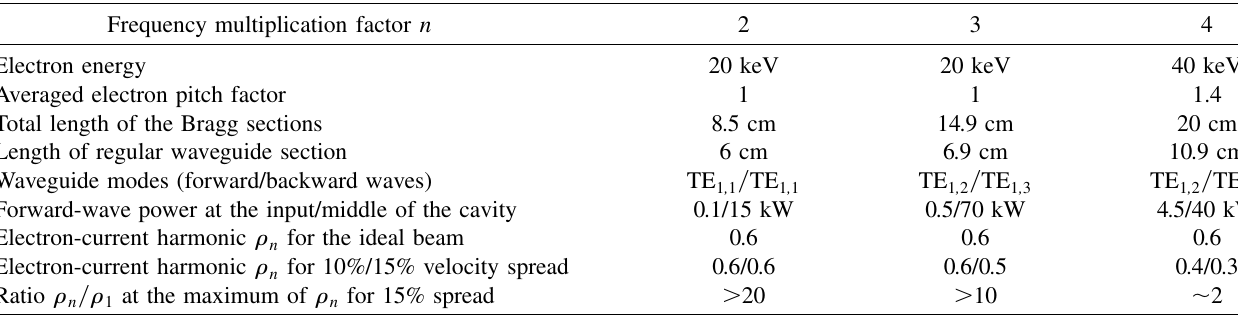
TABLE I. Parameters and results of numerical simulations.